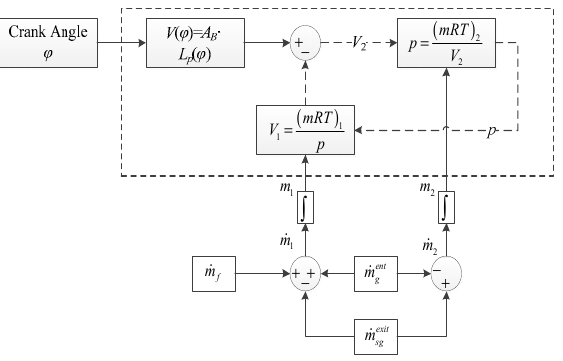
Figure 3. Volume balance of the two zones.